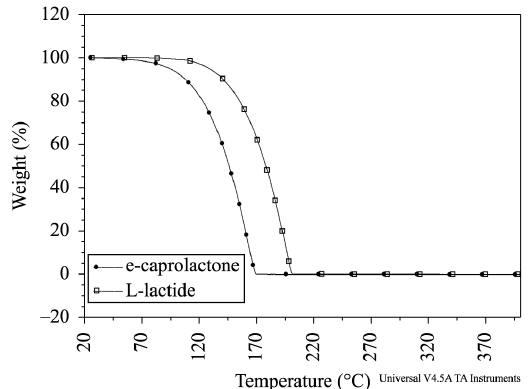
Figure 3. TG curves of LLA and CL monomers.